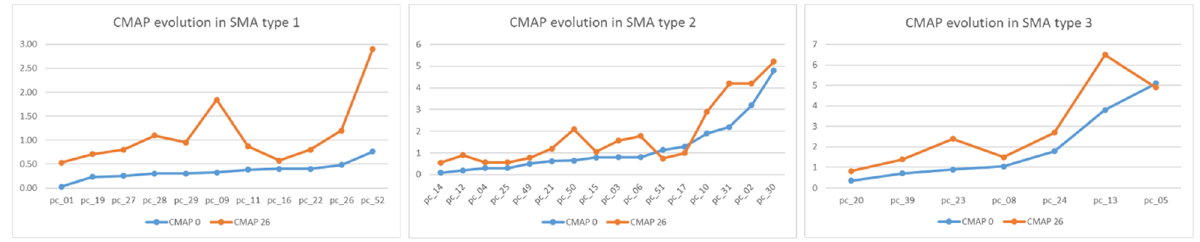
Figure 2. CHOP and HFMSE evolution at T0 and T26 for each type of SMA.